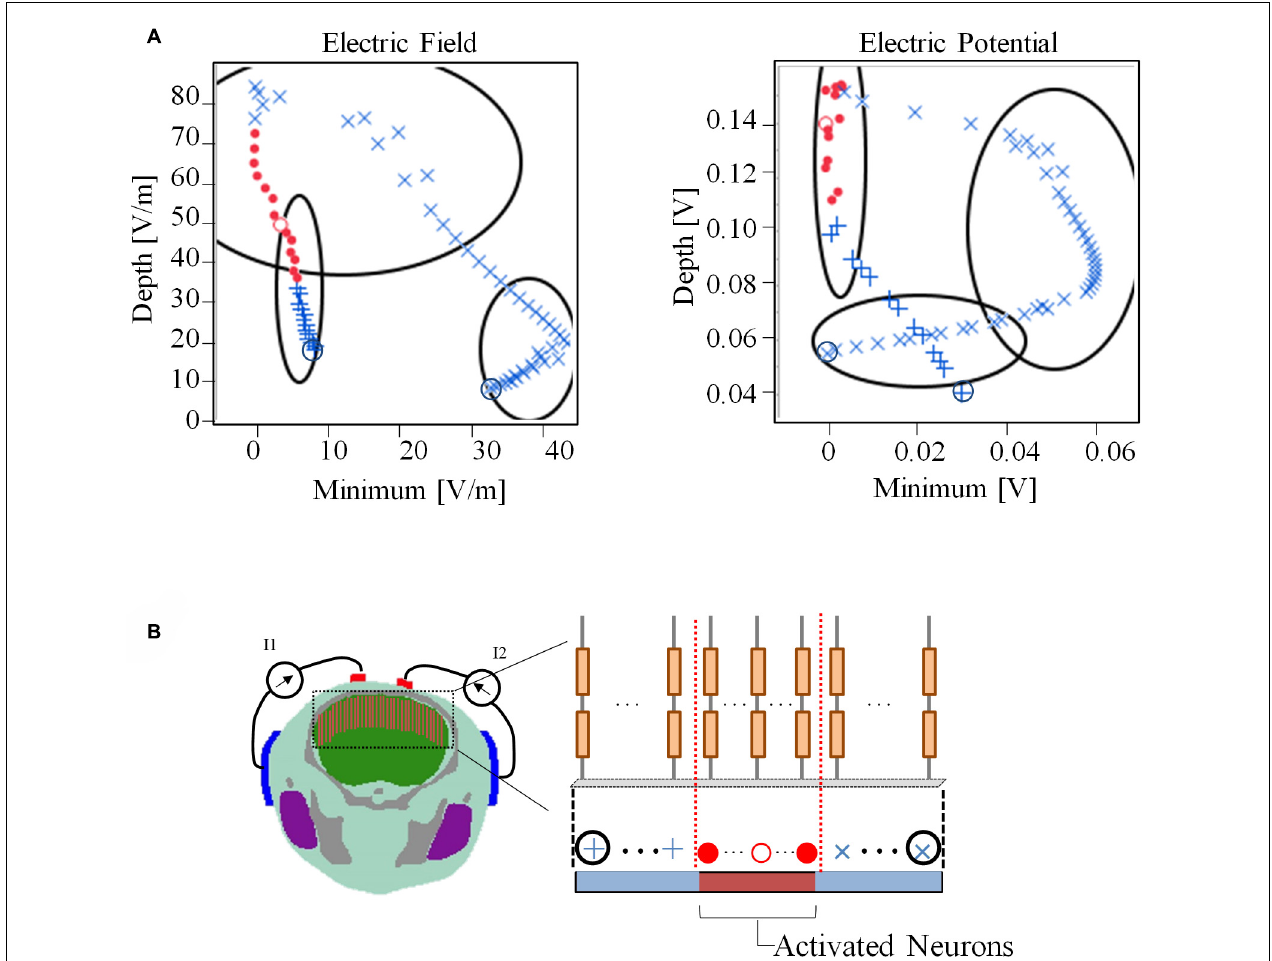
FIGURE 7 | (A) Relationship between depth and minimum of the envelope for detection of activated neurons using electric field and electric potential. The regions have been separated into three groups based only on the depth and minimum values using hierarchical clustering. (B) The activation state (active or non-active) is coded in red and blue colors based on the multiscale model results. Consecutive neighboring nerve positions follow the path (+, · , × ). The values of the electric field and electric potential are the averages along the